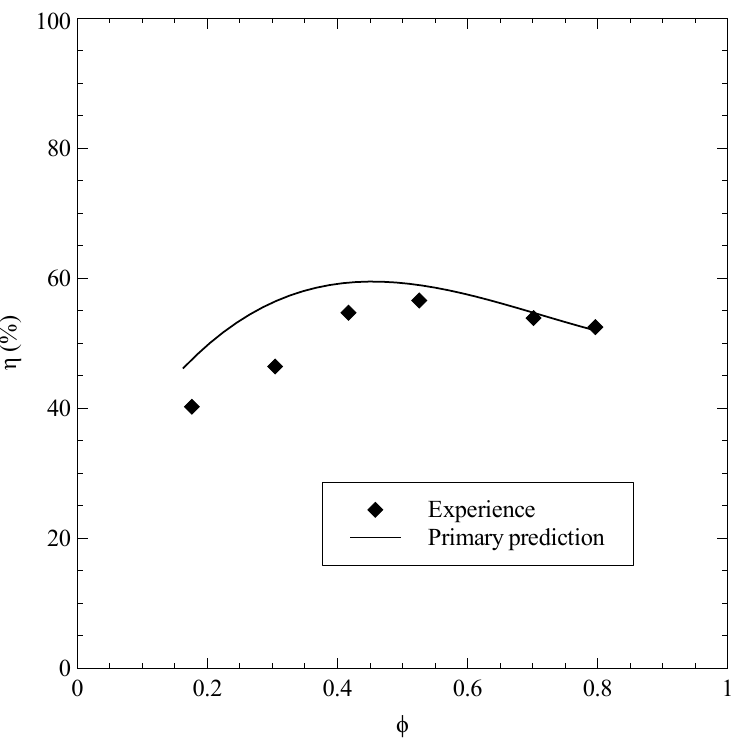
Figure 17. Efficiency prediction considering a constant size of the